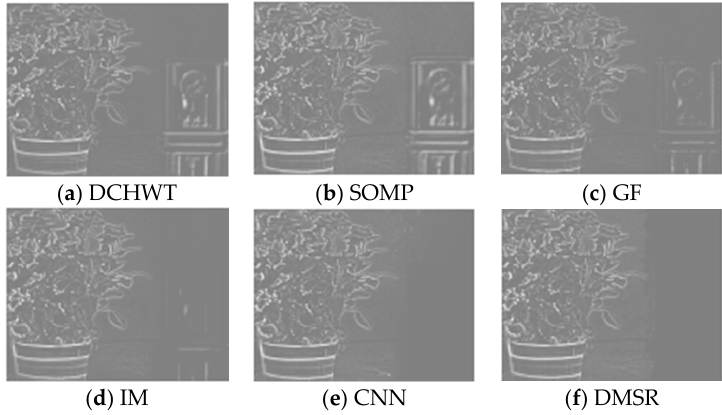
Figure 10. The “Flowerpot” source images and fusion results obtained by different fusion methods. Appl. Sci. 2019 , 9 , x FOR PEER REVIEW